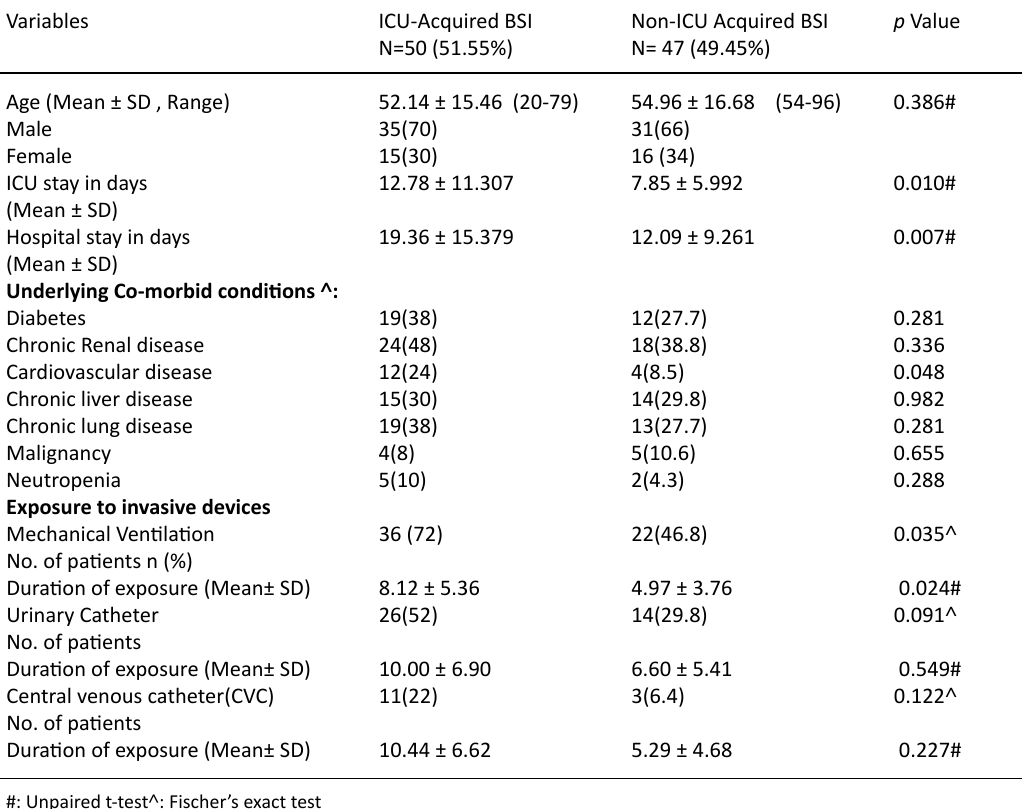
Table 1. Effect of patients related characteristics on the susceptibility of acquiring BSI